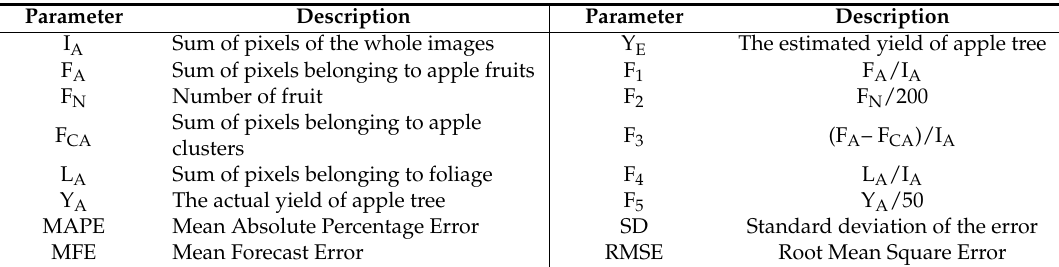
Figure 1. Sample apple tree at different times; left picture ( a ) was acquired in the early period after the June drop (period 1), about 3 months before harvest, right picture ( b ) was acquired during the ripening period (period 2), about 15 days before harvest.